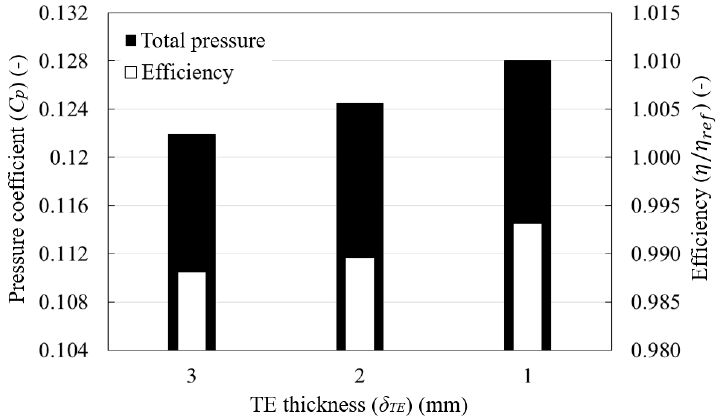
Figure 22. Performance with di ff erent trailing edge thickness treatments ( Φ / Φ des = 1.0).